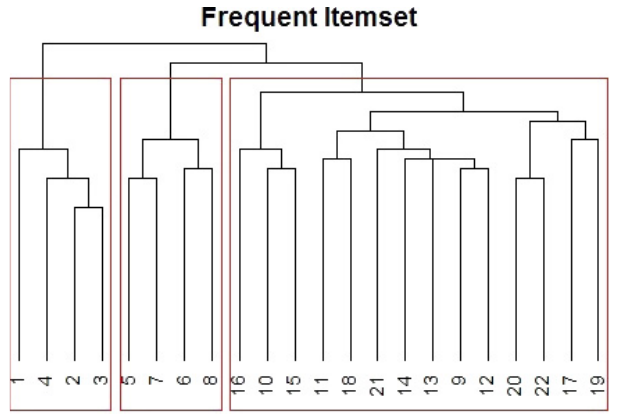
Fig. 7. Ascending hierarchical clustering using frequent itemsets.